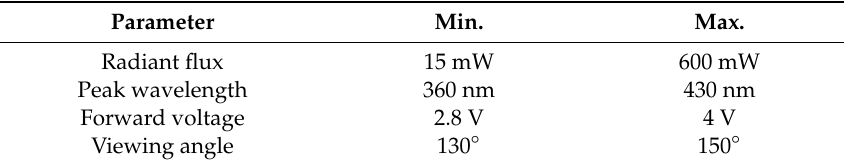
Figure 4. The design variables S1 and S2 .